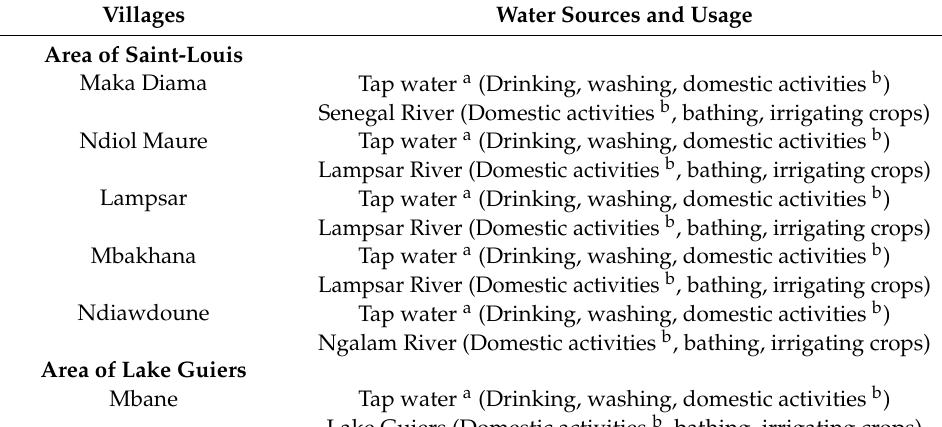
Table 1. Water supplies and usage in the 10 Senegalese villages